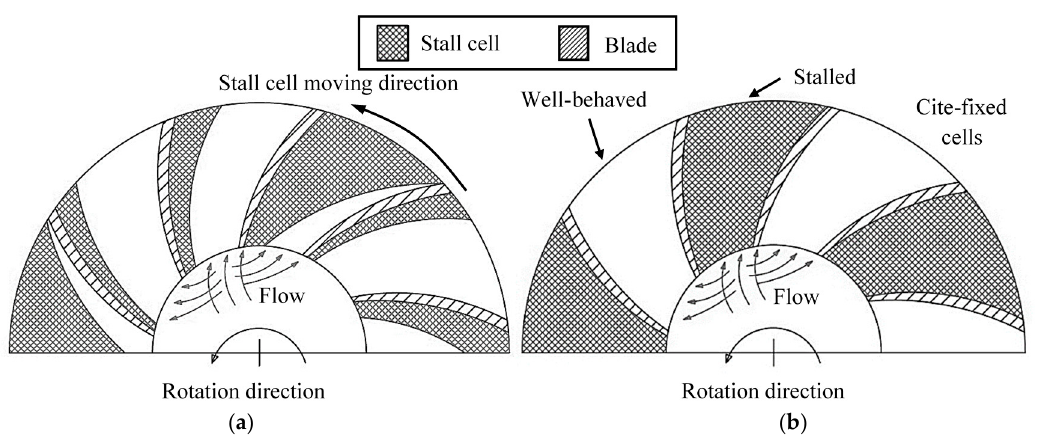
Figure 1. Schematic map of rotating stall in centrifugal impeller at partial-load: ( a ) rotating stall with cell-moving; ( b ) alternating stall with cite-fixed cells.